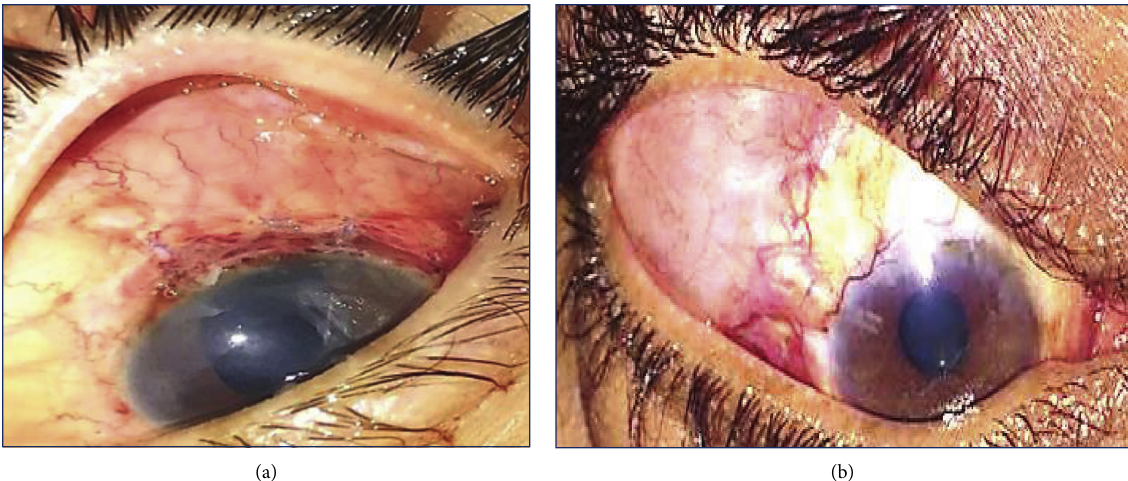
Figure 3: (a) A slit lamp biomicroscopy photo of a male patient in group I with IOP at 15mmHg revealed a thin bleb with minimal vascularisation (3 months after surgery). (b). A slit lamp biomicroscopy photo of a female patient in group II with IOP 28mmHg revealed a vascularised encysted bleb (1 month after surgery).